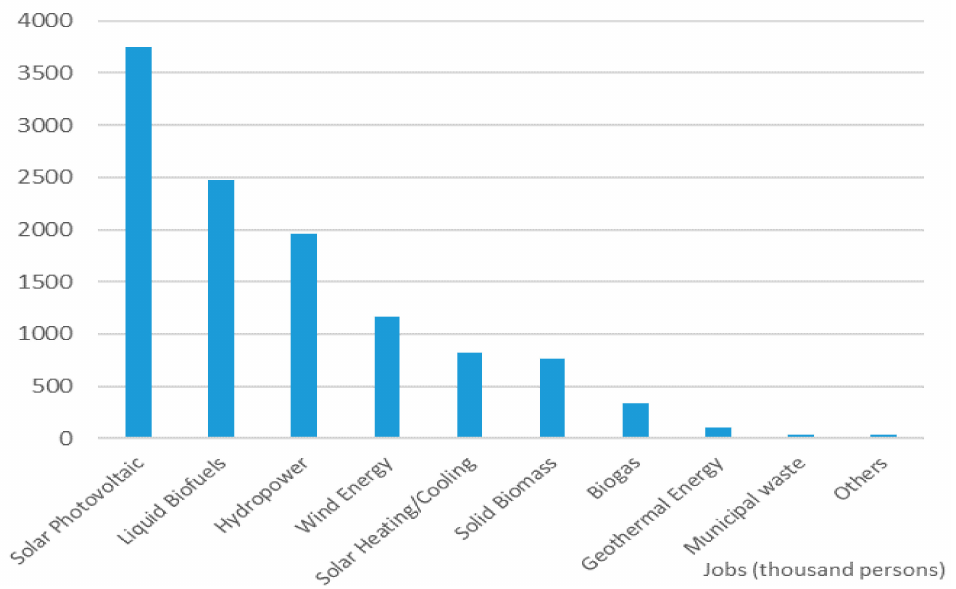
Figure 5. RE employment by technology in the world. Own elaboration based on data from [75]. Table 7. Number of enterprises producing RE equipment in Poland. Own elaboration based on data from